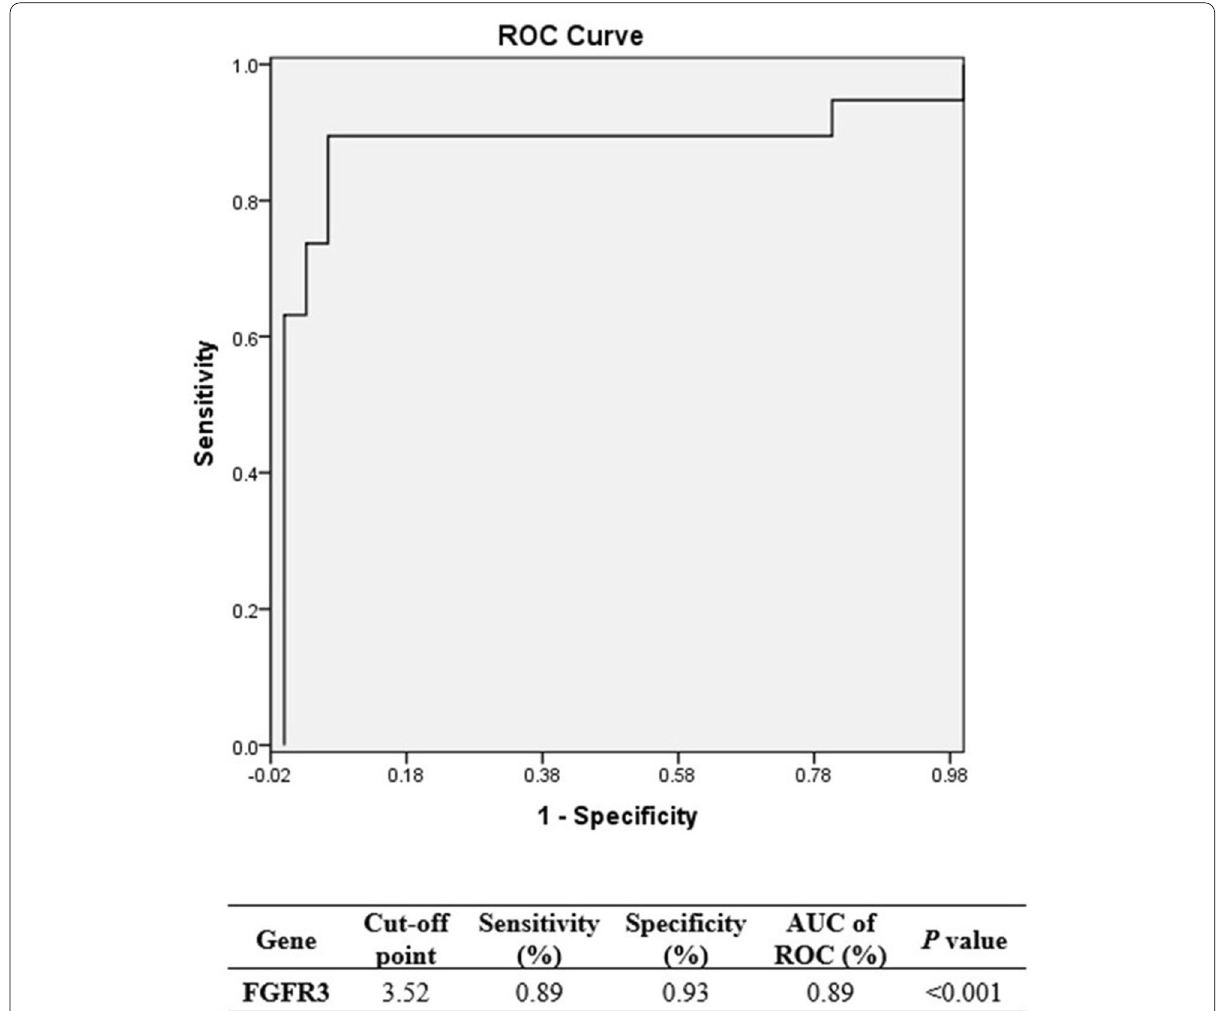
Fig. 3 Receiver operating characteristic (ROC) curves were performed to determine the area under the ROC curve (AUC), sensitivity, specificity, and p ‑value to determine the levels of the FGFR3 that best differentiate the UTUC versus the UBC. The optimal cutoff values were calculated as the marker level that maximizes the sensitivity and